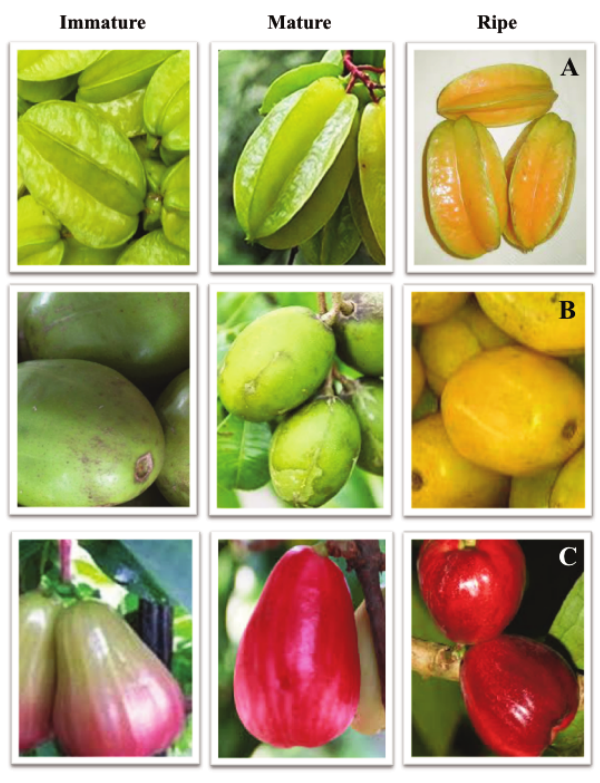
Fig. 1 ­ Carambola (A), June plum (B) and otaheite (C) at diffe­ rent development and ripening